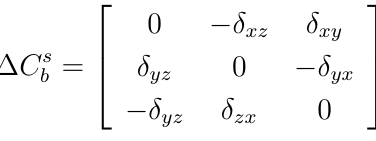
y z and X s s s